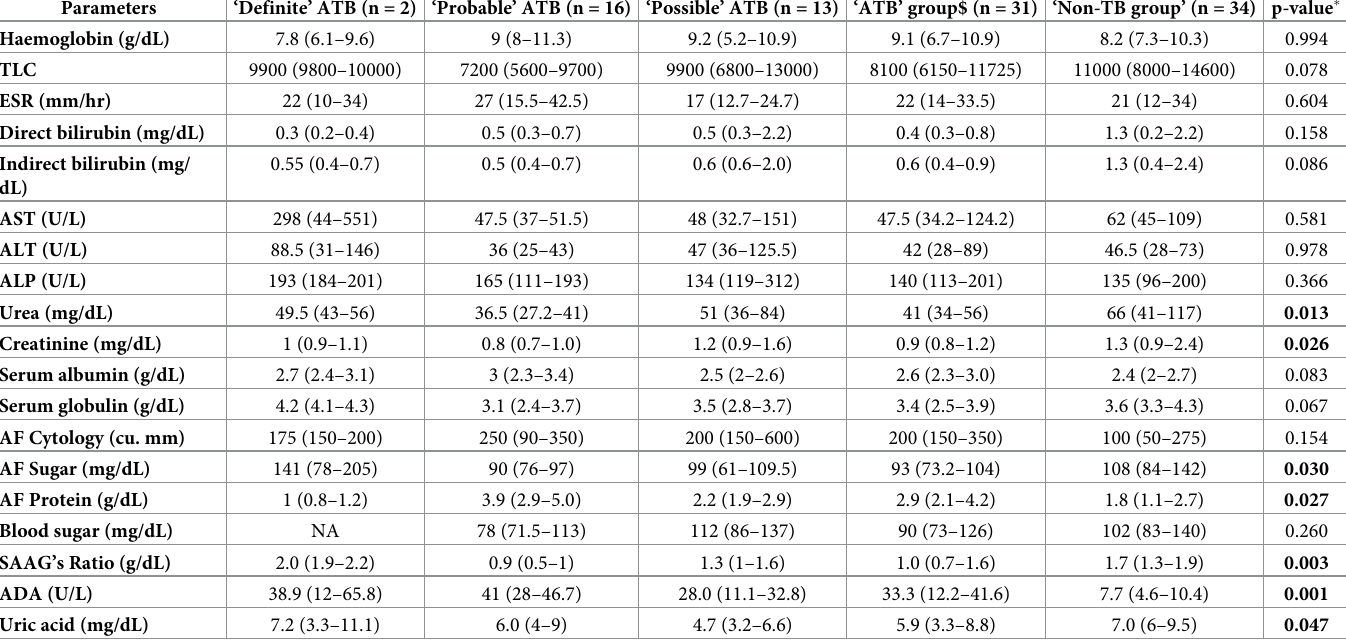
Table 2. Laboratory findings in enrolled study participant’s # .